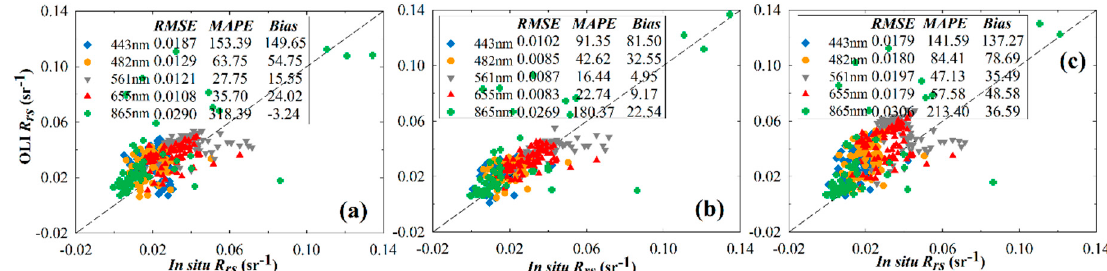
Figure 5. Scatter plots of R rs retrieved by land-AC algorithms (FLAASH ( a ), 6SV ( b ), and QUAC ( c )) versus in situ R rs .